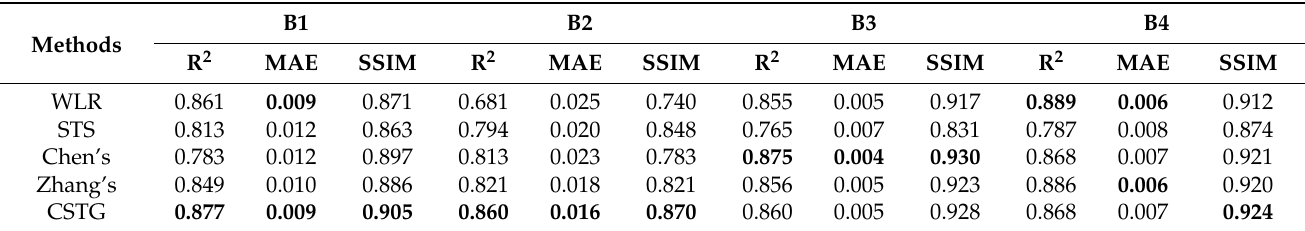
analysis of the normalized reflectance; ( c ) regression analysis of the NDVI. In ( b , c ), the solid red lines denote the regression lines and the dashed black lines denote the 1:1 lines. Table 3. The evaluate metrics between recovered reflectance values using different methods and original reflectance values derived from MOD09A1 for single band at large missing areas. A large and intensive mask was applied to the original images. The values in bold are the best values for each metric.